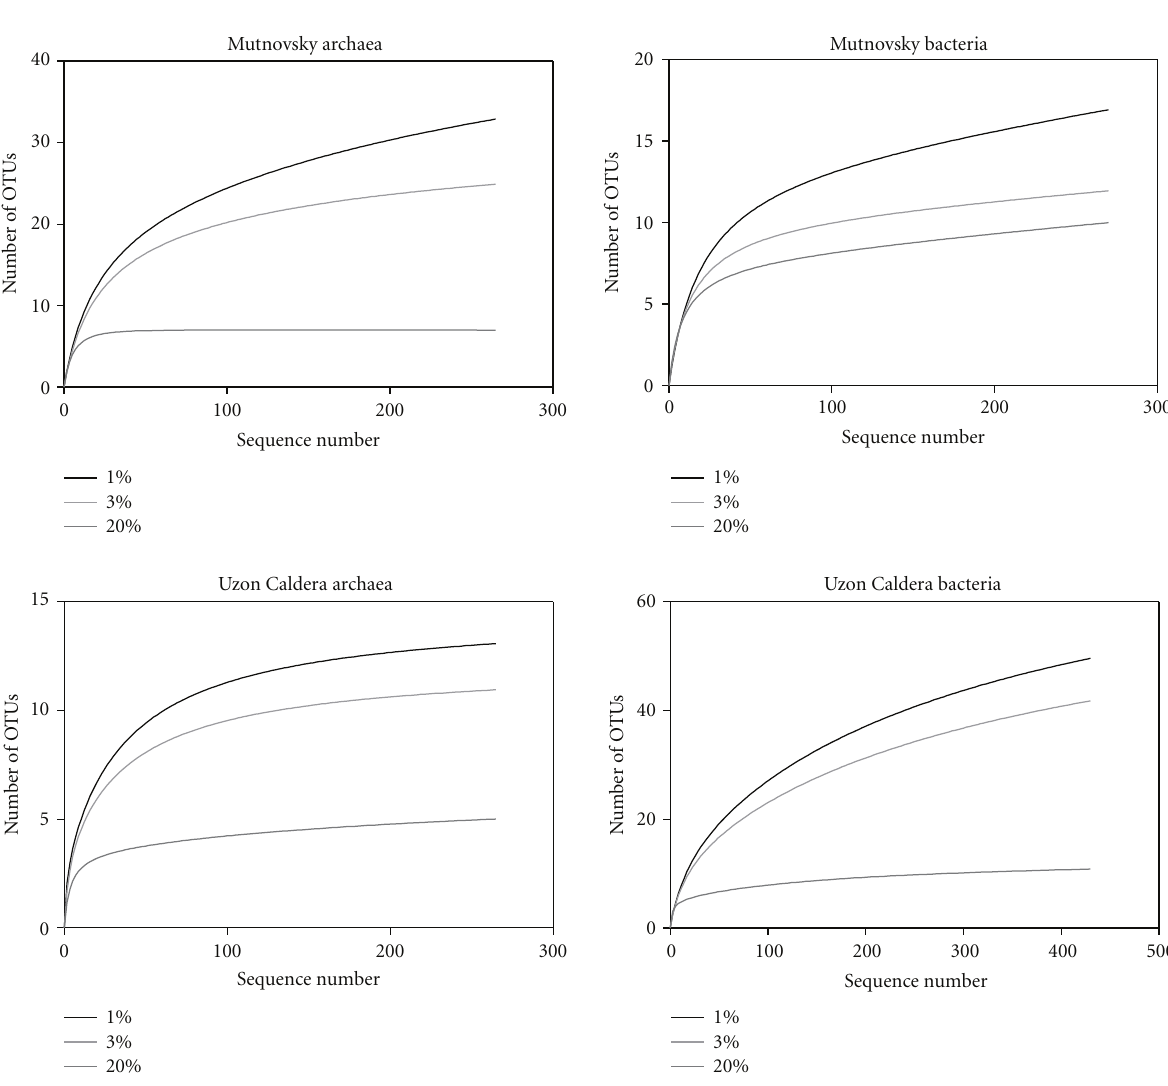
Figure 4: Rarefaction curves for both sampling sites. Curves were calculated at 1%, 3%, and 20% genetic distance level employing QIIME